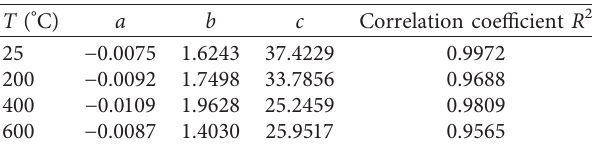
Figure 10: Relationship among reflected energy, transmitted energy, and absorbed energy of limestone with incident energy. (a) Reflected energy. (b) Transmission energy. (c) Dissipation energy (absorbed energy). Table 1: Parameter values of dynamic compressive strength and incident